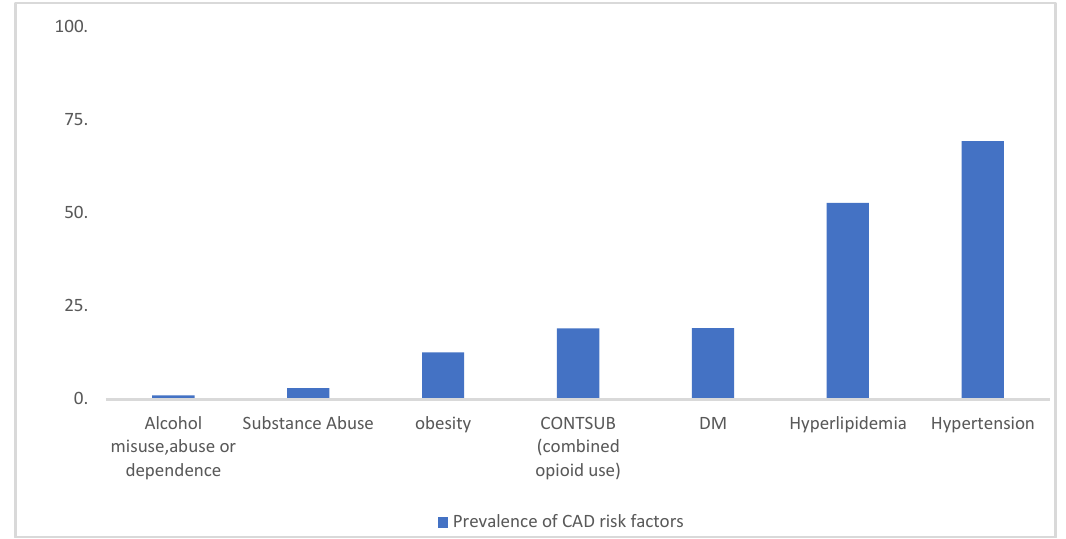
Figure 1. Prevalence of selected risk factors of CAD from the 2015 NAMCS data. Date source: Centers